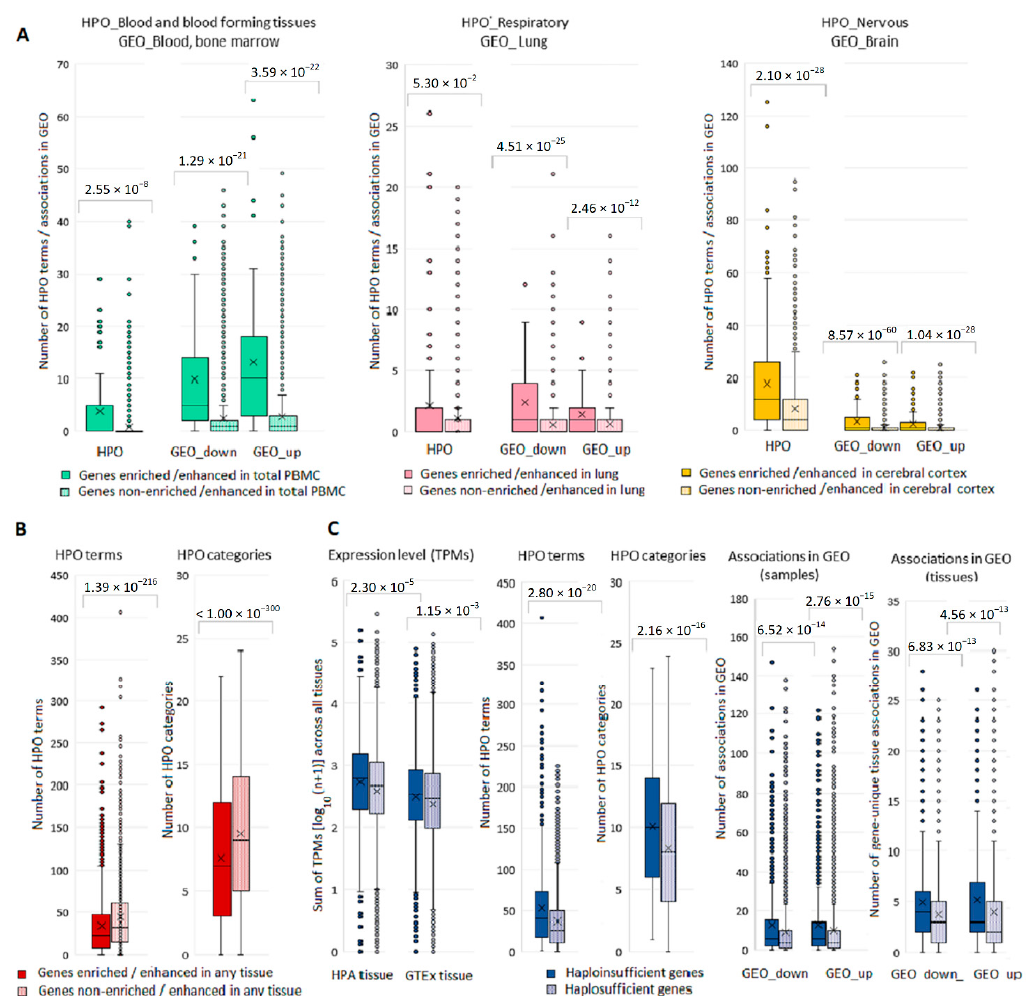
Figure 5. Box-plots depicting differences in the number of phenotypic associations and associations gene expression—disease in GEO for tissue specific and haploinsufficient genes. ( A ) Tissue-specific and non-specific genes with the number of terms within relevant phenotypic categories and the number of GEO samples, in which expression changes in relevant tissues were registered. ( B ) Tissue-specific and non-specific genes (in any tissue) with the number of terms and categories from the entire pool of HPO terms/categories. ( C ) Haploinsufficient and haplosufficient genes and their TPM sums across all tissues in HPA and GTEx, number of associations with HPO terms and categories and number of GEO samples and tissues, in which expression changes were recorded.